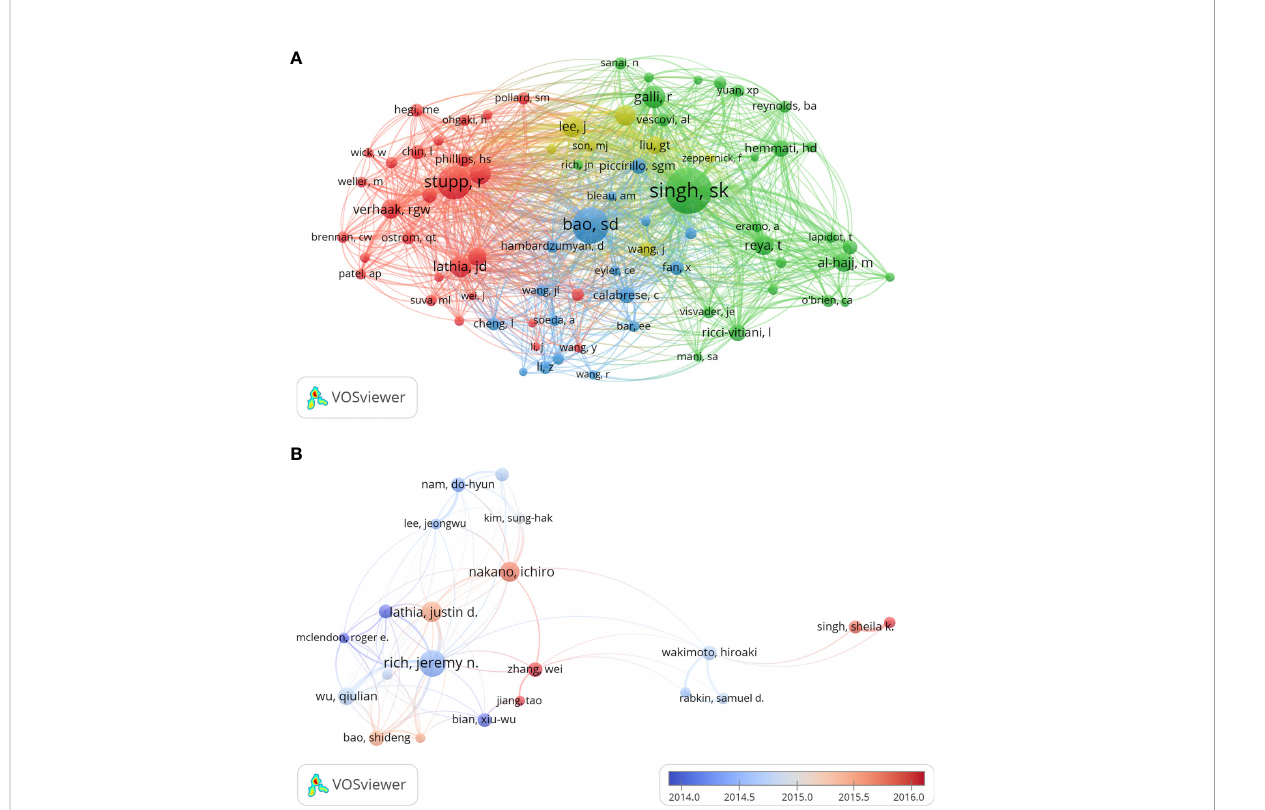
FIGURE 7 The author co-citation network map (A) and co-authorship overlay map (B) generated by VOS viewer. Each node represents an author, and node size indicates the number of publications. The purple nodes represent the author appear earlier, whereas the red nodes re fl ect the recent occurrence.